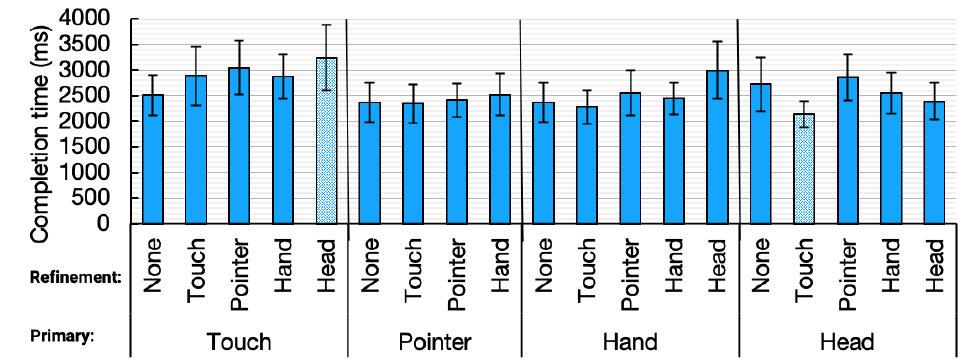
Figure 4. Mean times with different interaction techniques. Error bars represent the standard deviations and the pattern filled bars annotate the fastest and slowest technique.